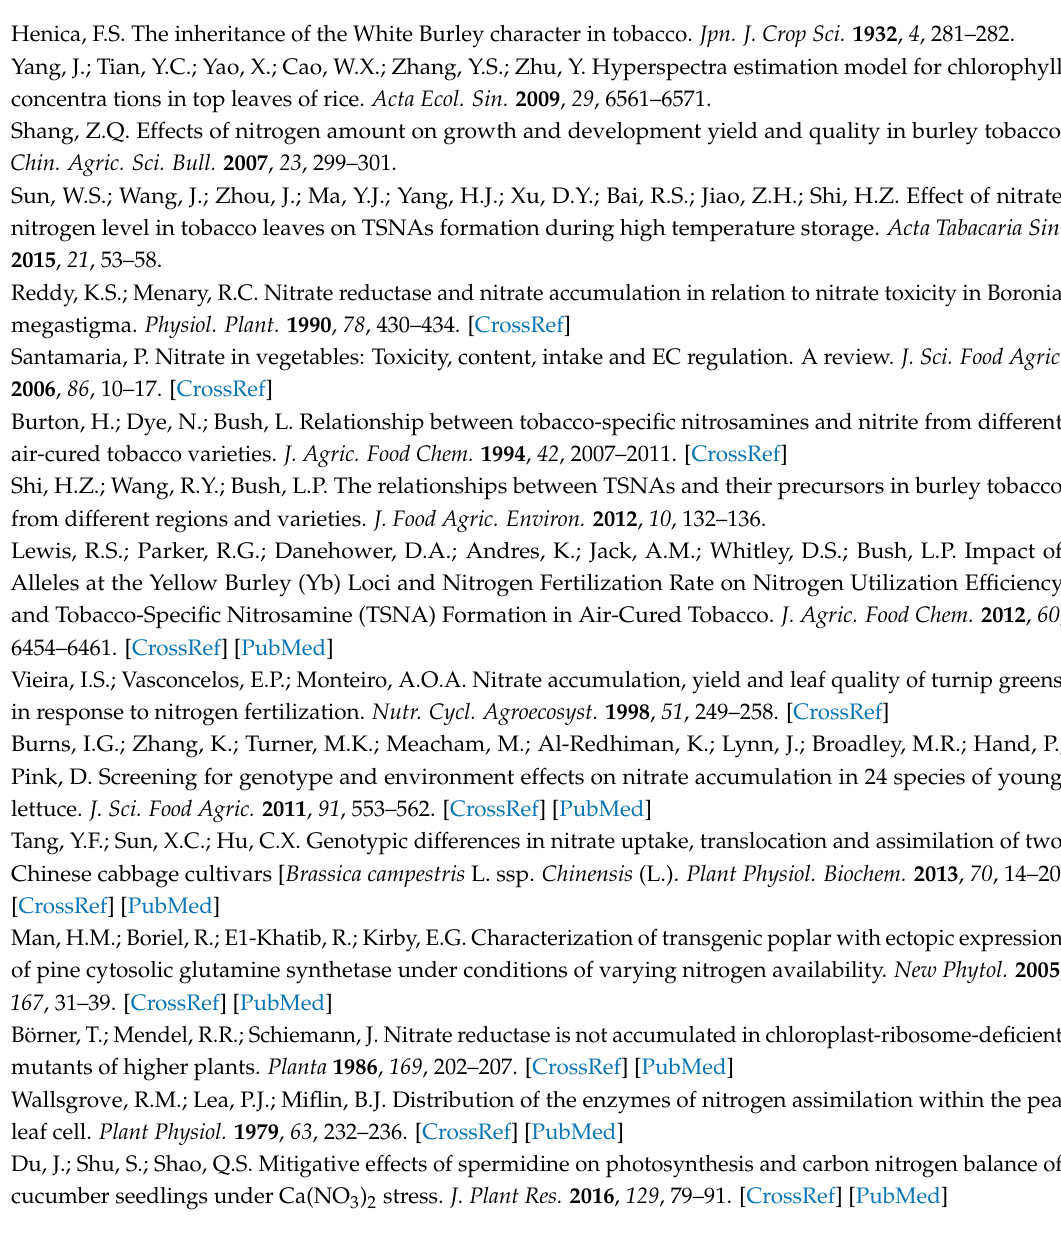
Supplementary Materials: Supplementary materials are available online, Table S1: Gene Table for Profile 38 biological replications. Table S2: Gene Table for Profile 73 (0.0, 0.0, 1.0, 1.0, 1.0, 1.0) correlated with carbon and nitrogen metabolism. Date are means of three biological replications; Table S3: The primers used in real-time